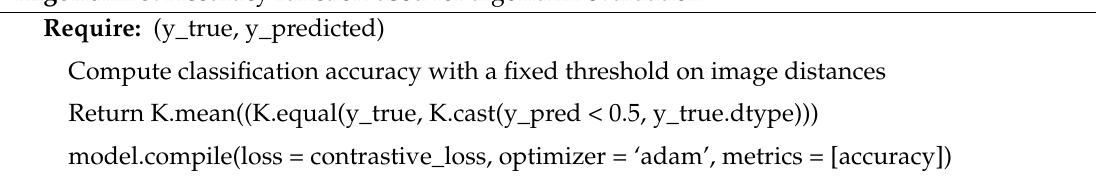
Algorithm 3: Accuracy function used for algorithm evaluation.